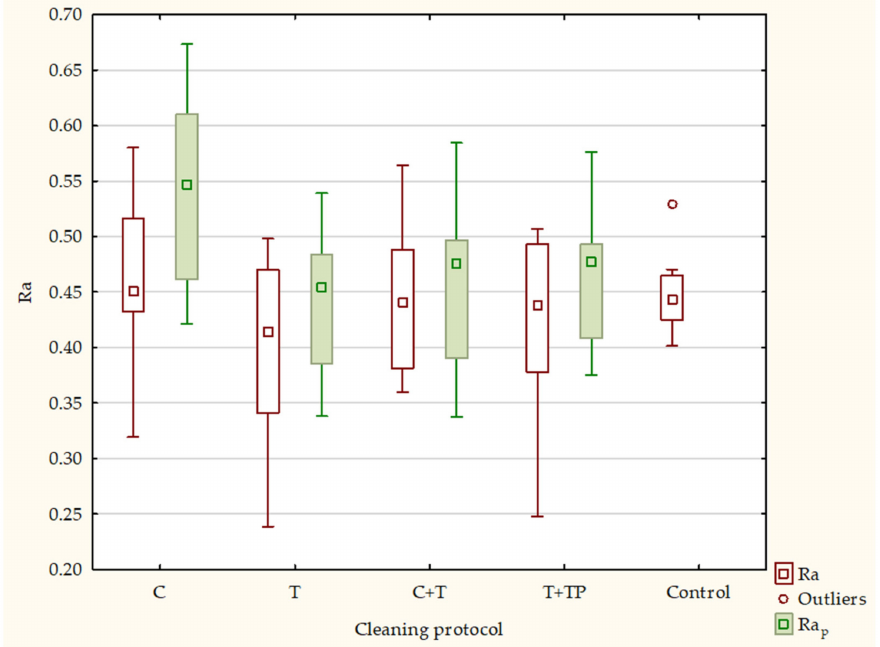
Figure 3. Surface roughness of the Erkodur-A1 bottom side in different cleaning protocols; median, box: 25–75%, whisker: non-outlier range; C—Corega, T—toothbrush, TP—toothpaste, Rap—surface roughness after cleaning